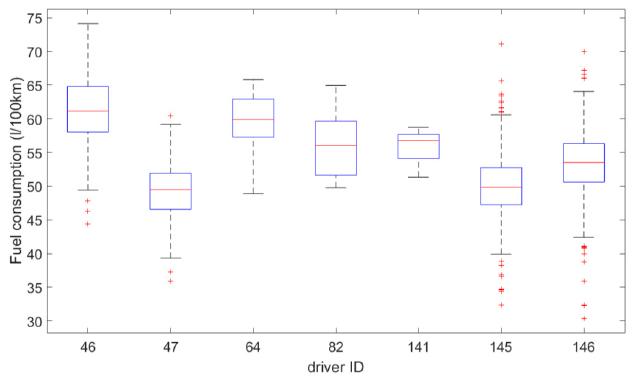
Figure 6. Influence of driver for the bus #15 and route #12.